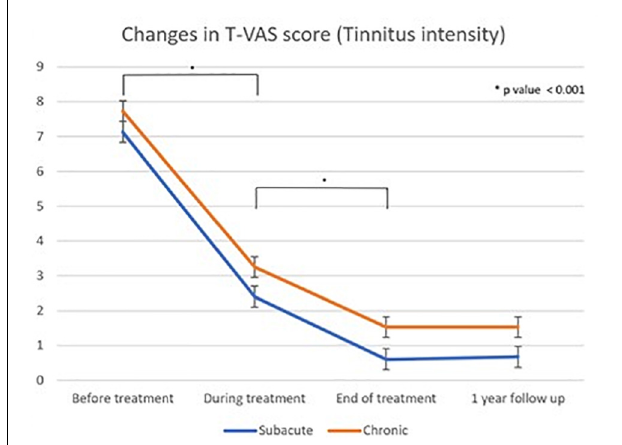
FIGURE 6 | Linear graph of the Dunnet T3 post hoc test of changes in T-VAS score (tinnitus intensity) as measured using the Tinnitus visual analog scale score between different treatment time points: subacute and chronic tinnitus group “During treatment” corresponds to 4th treatment session, “end of treatment” refers to cessation of all treatments, and “one year follow up” refers to 1 year after the first